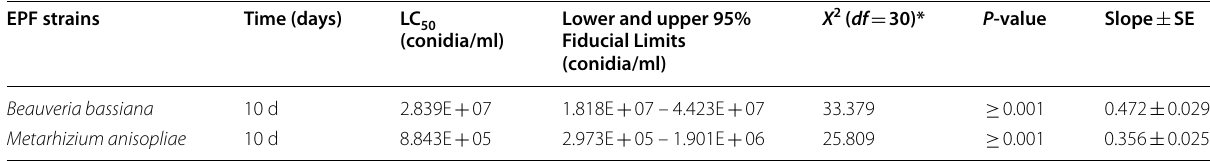
*Since the significance level is less than 0.150, a heterogeneity factor is used in the calculation of confidence